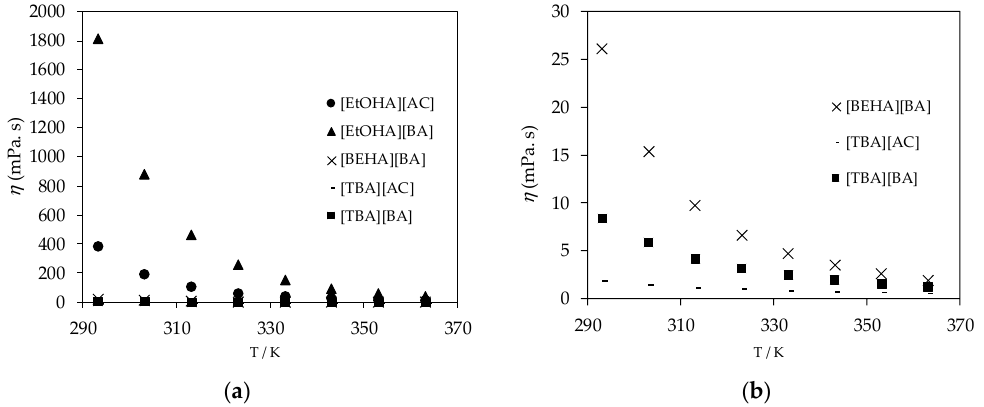
Figure 4. ( a ) Plot of experimental viscosity ( η ) values of ammonium based ionic liquids and ( b ) plot of experimental viscosity ( η ) values of [BEHA][BA], [TBA][AC], and [TBA][BA].